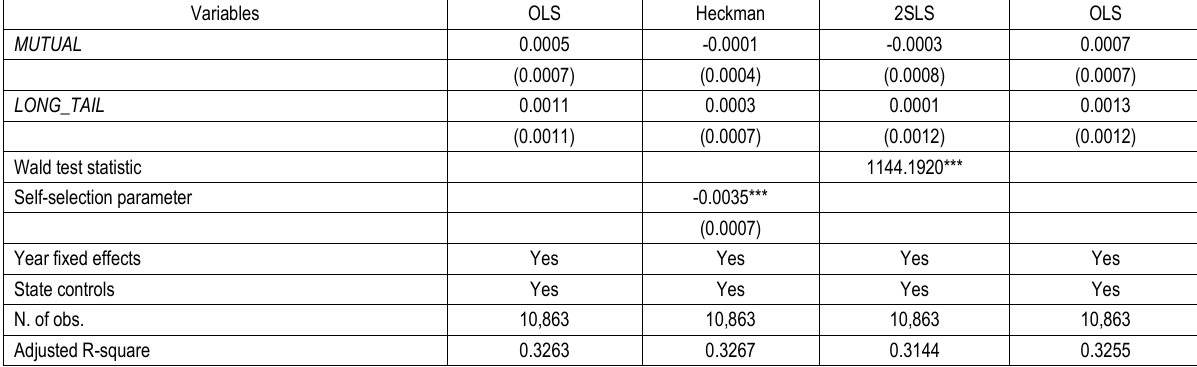
Table 3 (cont.). Diversification effect on investment